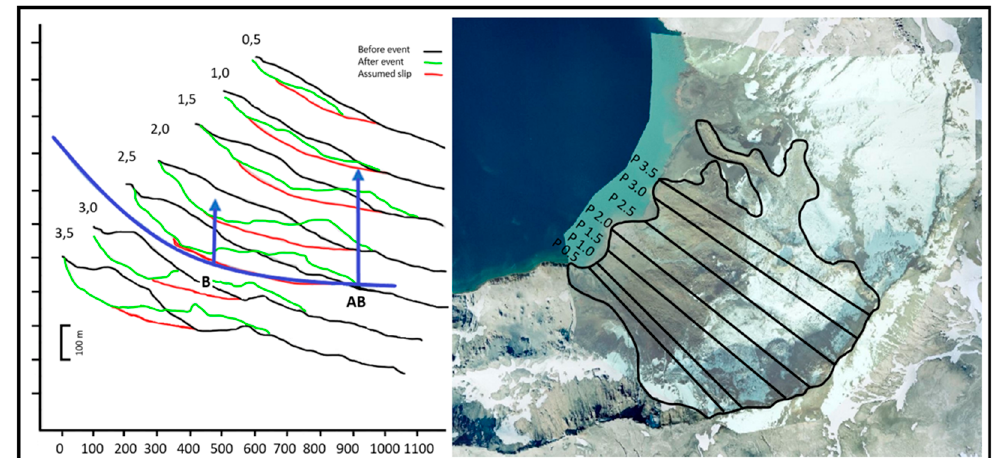
Figure 7. Longitudinal sections from the DEMs of the rockslide area from before (black curves) and after (green curves) the slide, above the water lake. The interpreted slip circle surface is marked by the reddish curves, modified from [59].